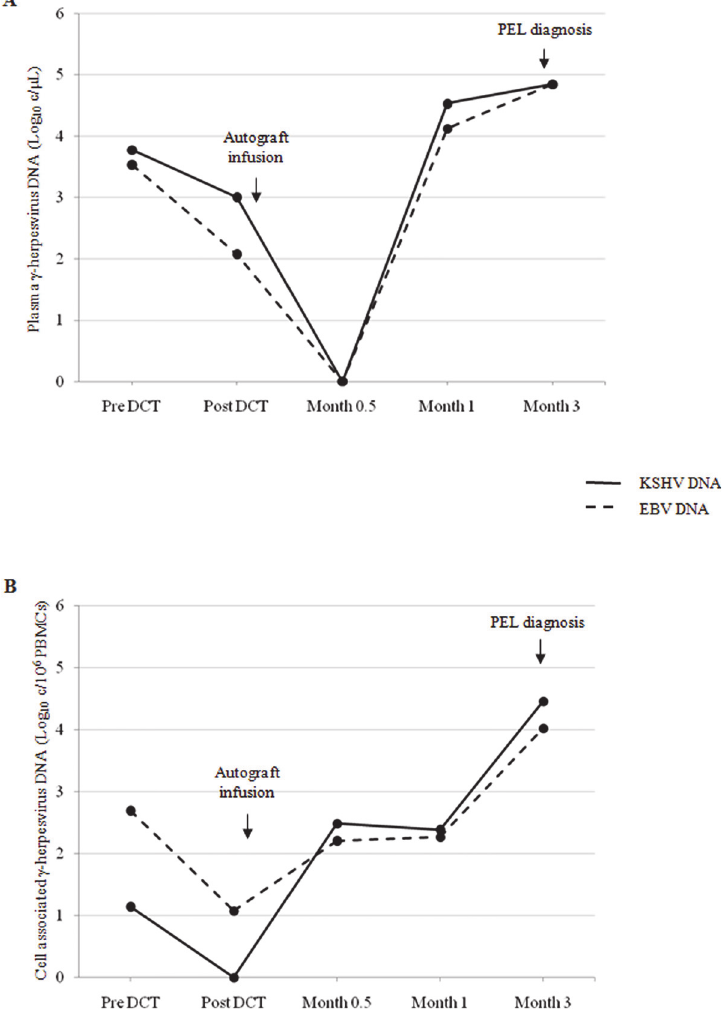
Figure 2. EBV-DNA (dashed line) and KSHV-DNA (solid line) load dynamics in plasma (A) and in PBMCs (B) during pre- and post- transplantation in patient #18. DCT, debulking